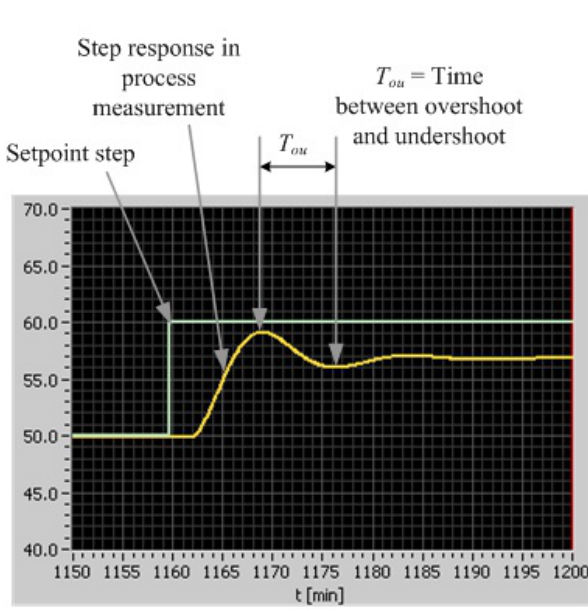
Figure 2: The Good Gain method: Reading off the time, T ou , between the overshoot and the un- dershoot of the step response with P con-